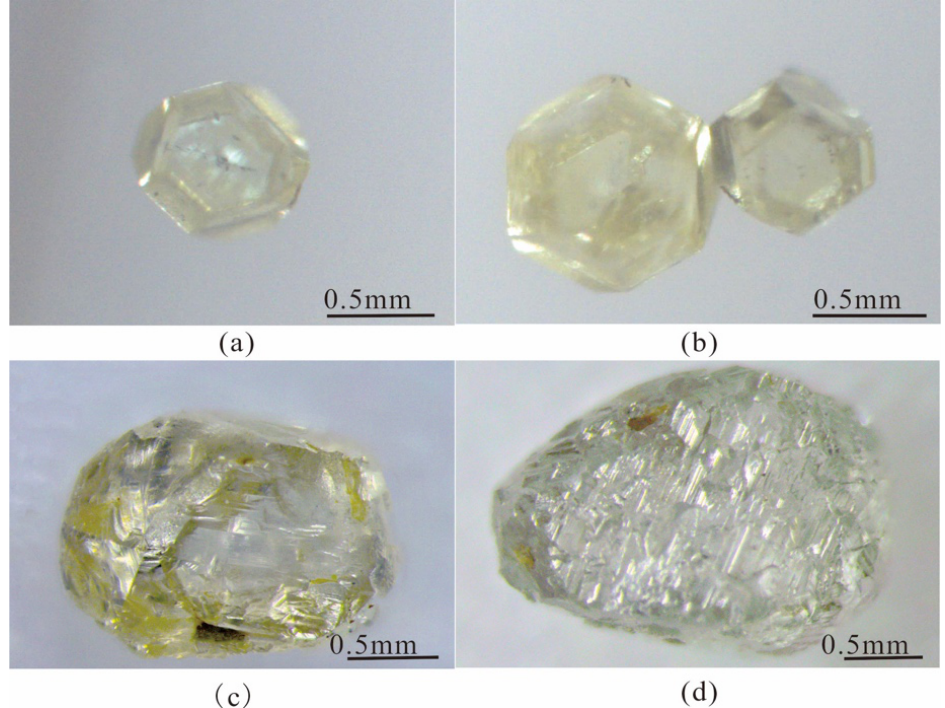
Figure 1. ( a ) Ib type AD microdiamond; ( b ) IaA/Ib type AD microdiamonds; ( c ) IaAB type AD microdiamond; ( d ) IaA type AD microdiamond. Table 1. Characteristic of the tested Diamonds.